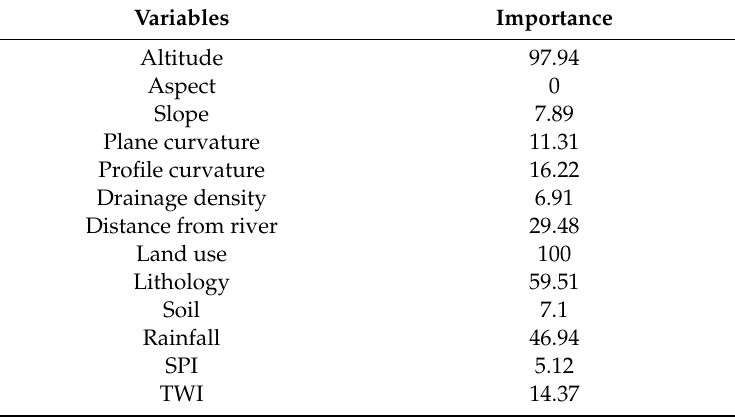
Table 8. Variable importance analysis based on the PSO-DLNN